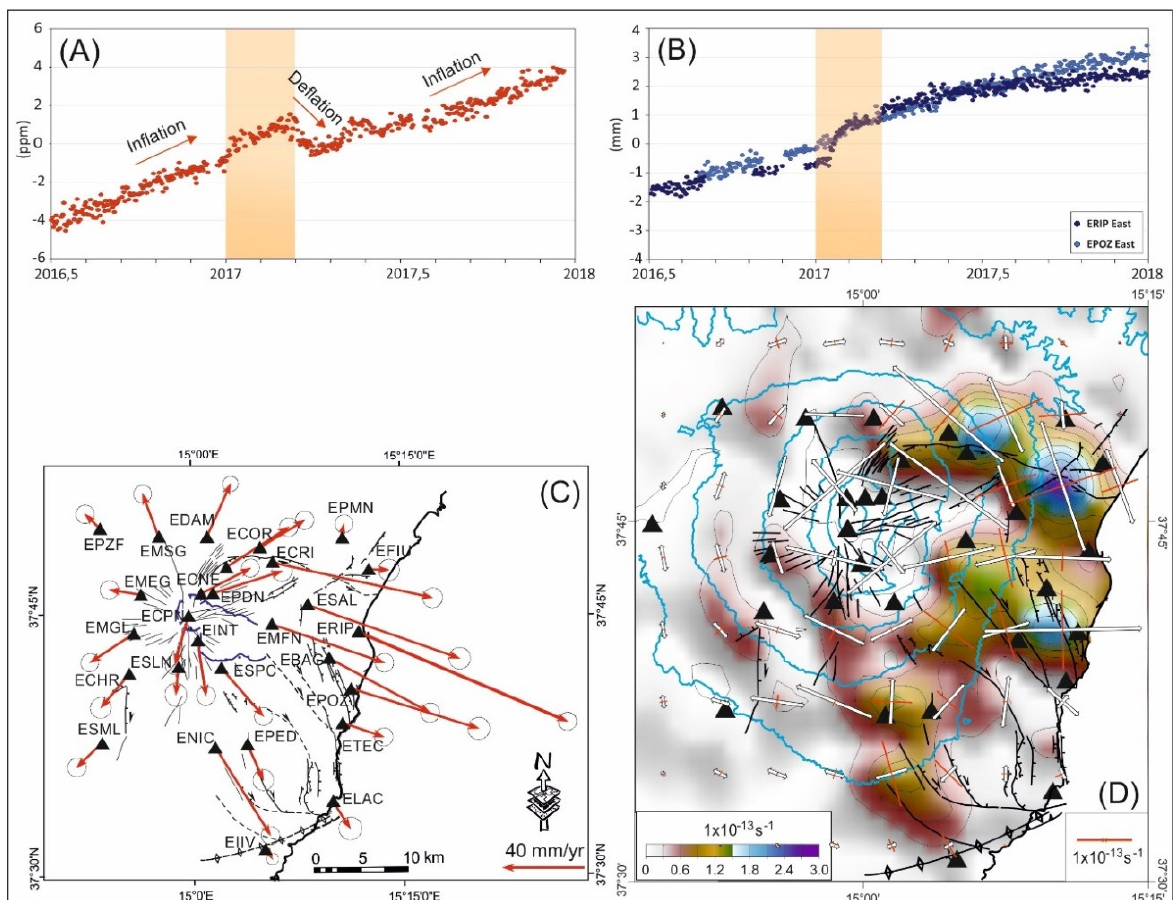
Figure 4. ( A ) Daily variation of the area recorded at an intermediate altitude triangle (EDAM- EMEG-EINT, see Figure 4C for GNSS station locations) from 1 July 2016 to the end of 2018. Positive variations (dilatations) indicate inflation, while the negative variation (contraction) was measured during the deflation of the volcanic edifice due to volcanic activity. The orange rectangle highlights the time interval that we analyzed in this manuscript (1 January 2017–15 March 2017). ( B ) Daily E–W components of ERIP (blue points) and EPOZ (light blue points) GNSS stations on the eastern flank of Mount Etna (see Figure 4C for locations); ( C ) Measured GNSS horizontal velocities with 95% confidence ellipses for the period 1 January 2017–15 March 2017; ( D ) Geodetic shear strain rate at Mt. Etna associated with the component of the strain tensor field. Principal axes of the average strain rates within the 0.05 × 0.05 grid areas are reported in the eastern flank. Open arrows indicate extensional strain rates and solid red arrows correspond to compressional strain rates. The strain rate was modelled through the inversion of the GNSS velocities shown in Figure 4C. The black triangles indicate the GNSS stations.